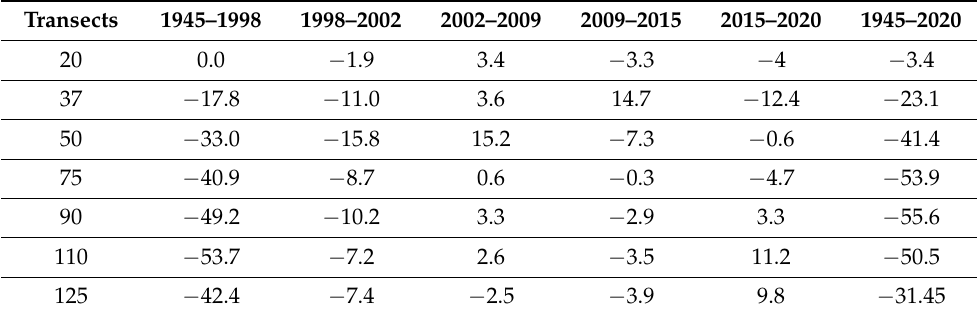
Table 2. Changes in the position of the broader beach coastline in meters, on selected transects (for location see Figure 5), during the period 1945–2020.